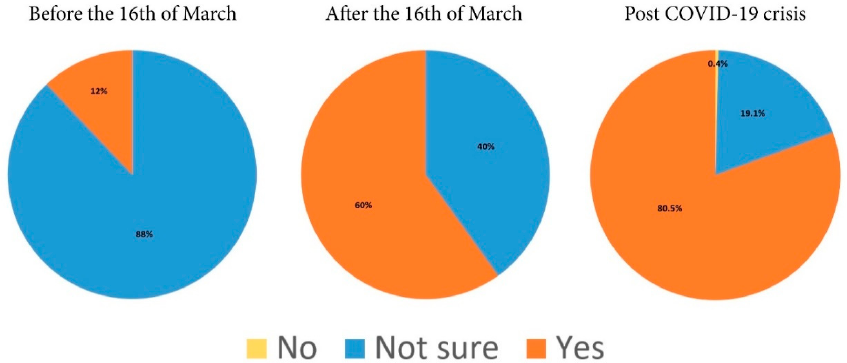
Figure 4. The distribution of answers concerning the purchasing decision of directly delivered fresh vegetables from producers, before and after March 16 and whether they will keep buying post COVID-19 crisis, related to the total number of respondents.